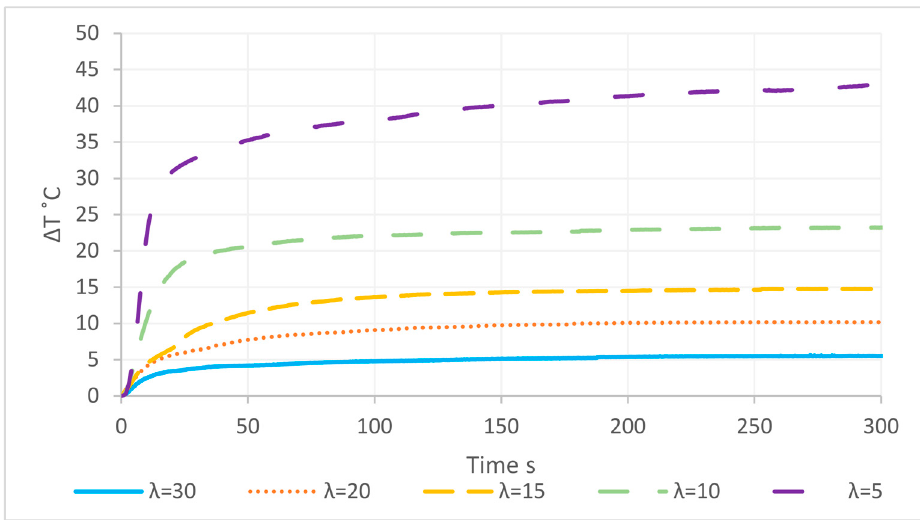
Figure 14. Temperature rise of the hydration reaction depending on different water surplus ratios ( λ ) with a common initial temperature of 25 °C [35].